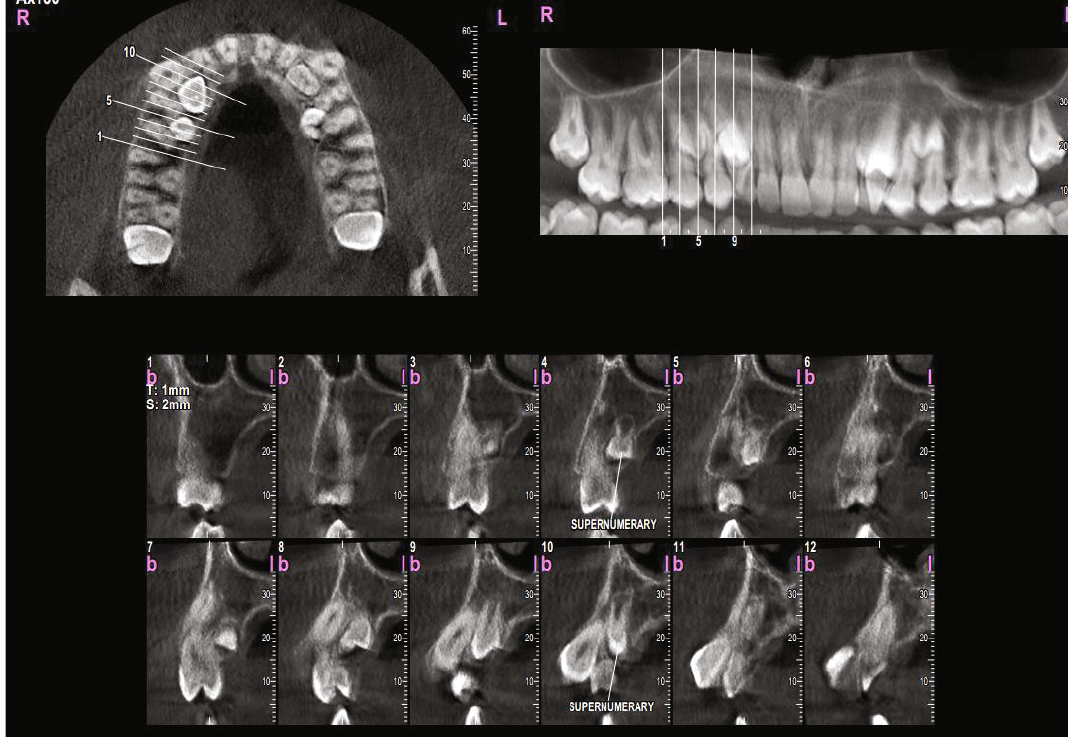
Figure 5: Vertical sections perpendicular to the alveolar ridge, showing the position and morphology of supernumerary teeth in the maxillary right quadrant.